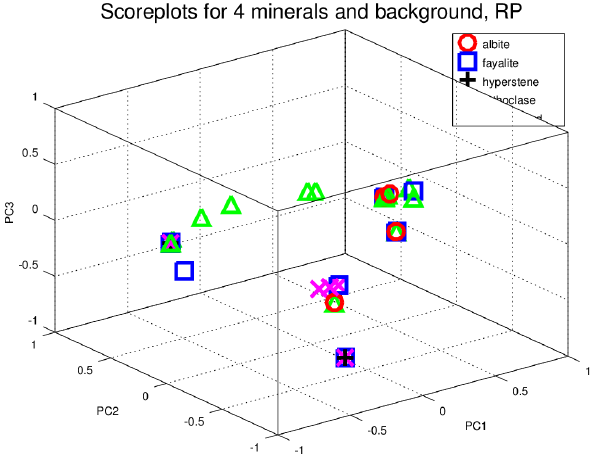
Figure 5. Score plot using the three first PCA components. The events represent the four minerals and the background for sub- strate 496.